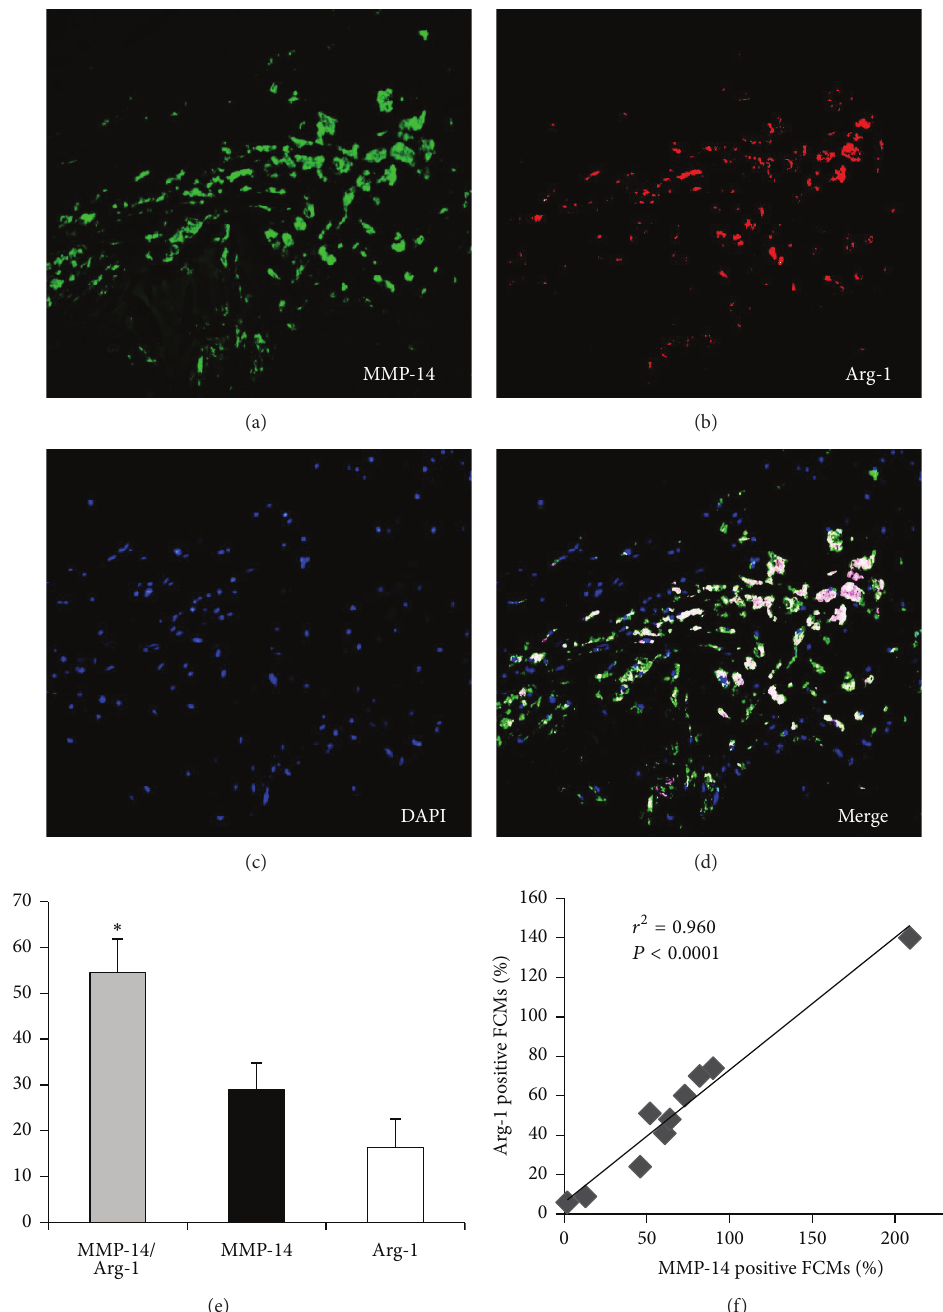
Figure 4: ((a)–(d)) Representative images of immunohistochemical labelling of advanced human carotid artery atherosclerotic plaques, for colocalisation of MMP-14 (a) with arginase-1 (b), with nuclei counterstained with DAPI (blue; (c)). Scale bar in (a) represents 100 𝜇 m and is applicable to panels (a)–(d). (e) The percentage of MMP-14 positive FCMs that also stained for arginase-1 was significantly greater compared to only MMP-14 or arginase-1 ( ∗ 𝑃 < 0.05 ; 𝑛 = 10 per group; data expressed as mean ± SEM). (f) Correlation of arginase-1 and MMP-14 positive macrophages in human carotid artery atherosclerotic plaques ( 𝑟 2 = 0.960 ; 𝑃 < 0.0001 ; 𝑛 = 10